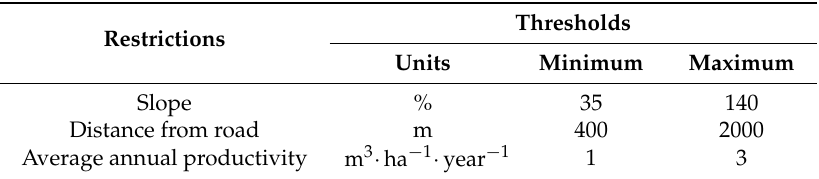
Table 1. Thresholds applied for the estimation of FAWS (Forest Available for Wood Supply) area applying the economic restriction of the FAWS definition